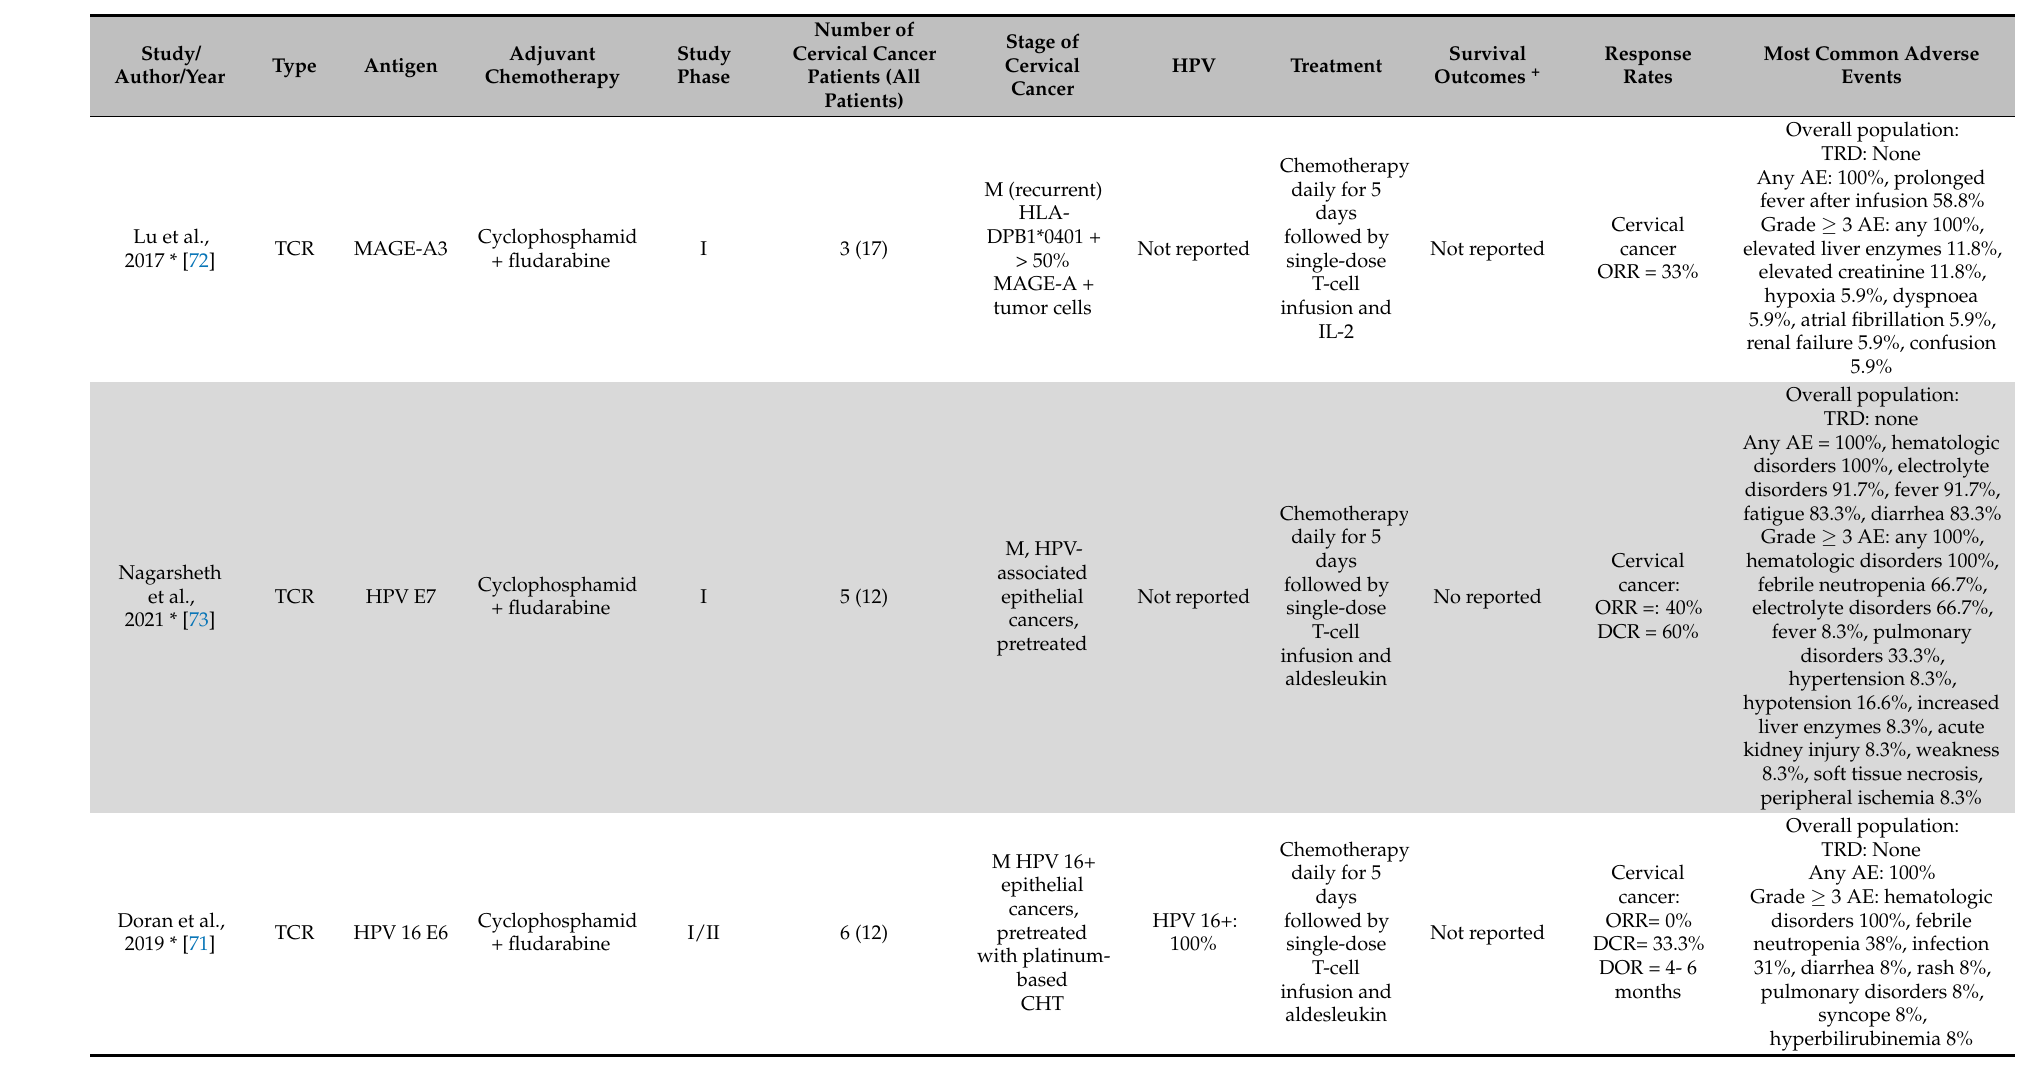
Table 4. Overview and results of clinical trials assessing adoptive T cell therapy in cervical cancer